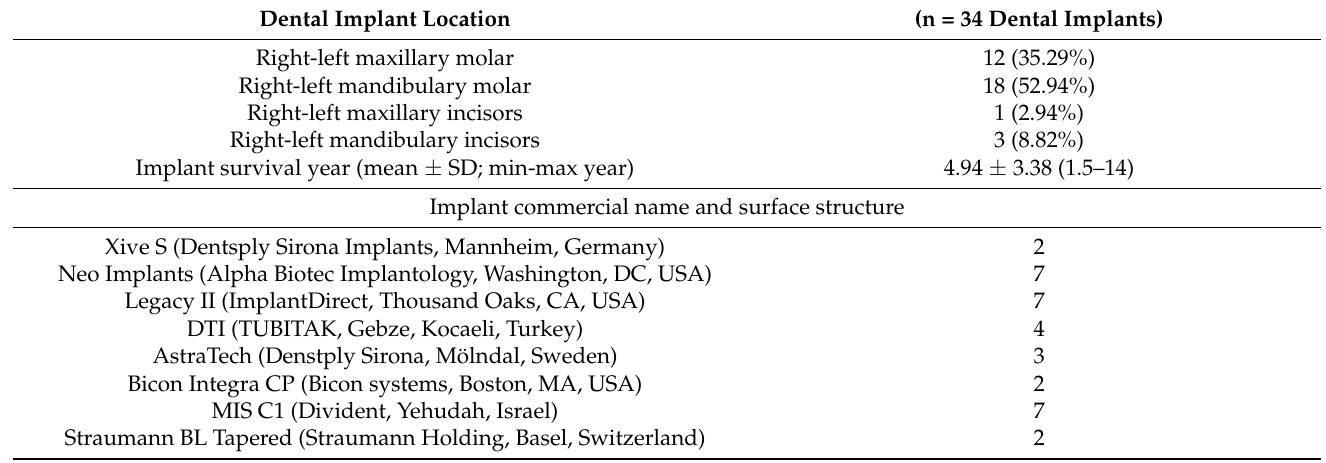
Table 1. Demographic data of the dental